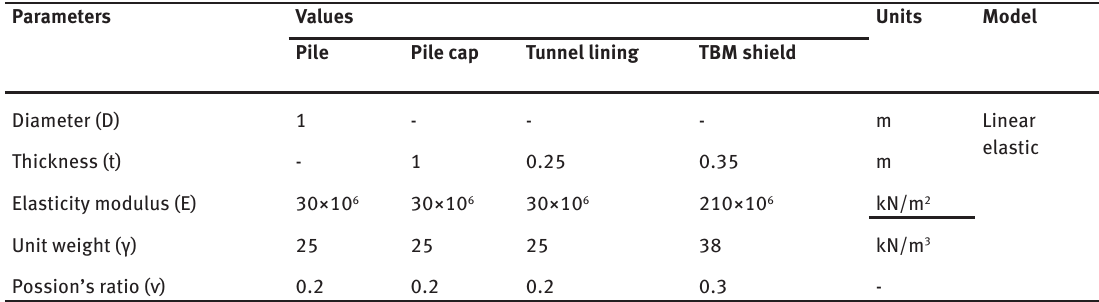
Table 1: Concrete parameters adopted in the numerical analysis. Parameters